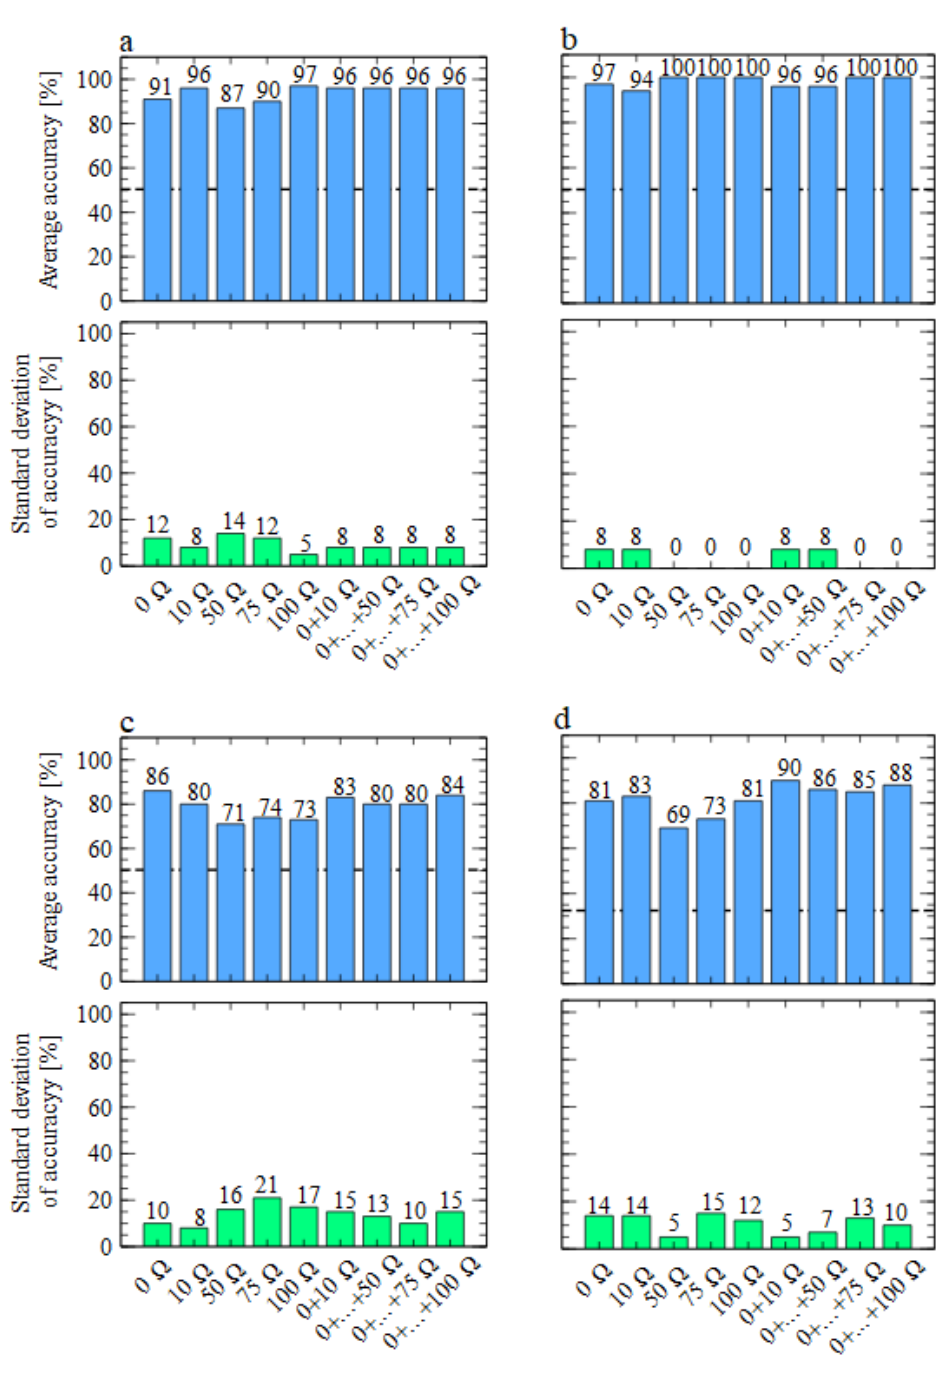
Figure 6. Performances of classification models, using data collected by the TGS 2603-type sensors with various heater voltages. Average accuracy and standard deviation of model accuracy were calculated in a cross-validation loop, as described in the main text. Binary or multinomial target classification is presented in subfigures. ( a ) Medium versus Fusarium . ( b ) Medium versus Rhizoctonia . ( c ) Fusarium versus Rhizoctonia . ( d ) Medium versus Fusarium versus Rhizoctonia . The bars represent various models built using a single sensor’s data or multiple sensors’ data, and the sensors are labelled by the resistances attached to their heaters. The horizontal line represents the null (random) model